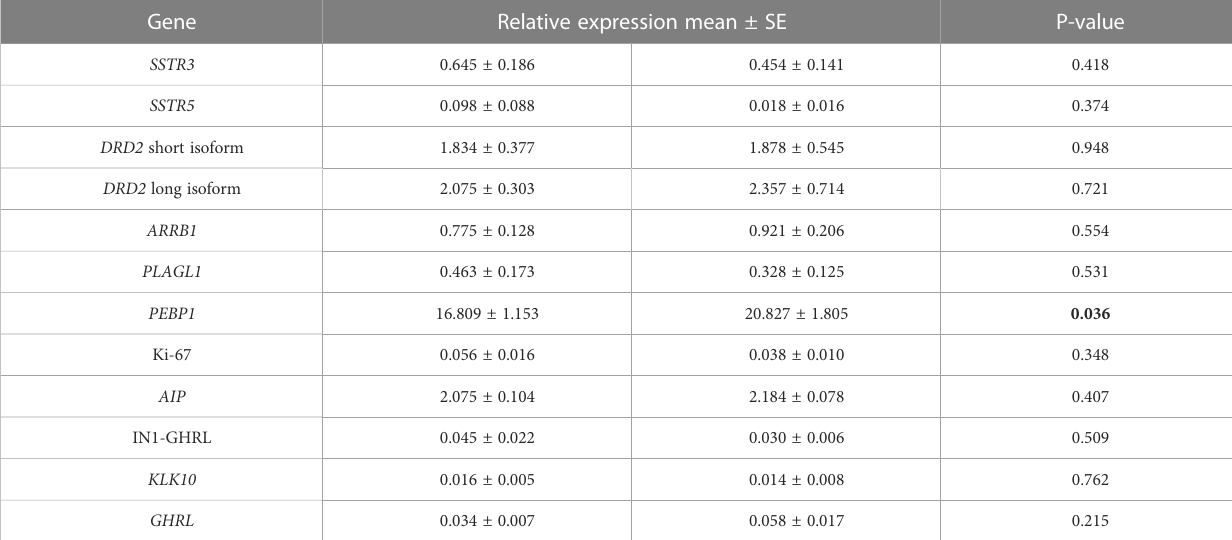
PitNETs the more prevalent receptor was DRD2, followed by SSTR3, while SSTR2 and SSTR5 presented a low expression (Figure 4A). In the case of GH-secreting tumors DRD2 was also the most quantitatively expressed, SSTR2 and SSTR5 were expressed at the same level as the SSTR3 in NF-PitNETs, while SSTR3 showed a very low expression level (Figure 4B).